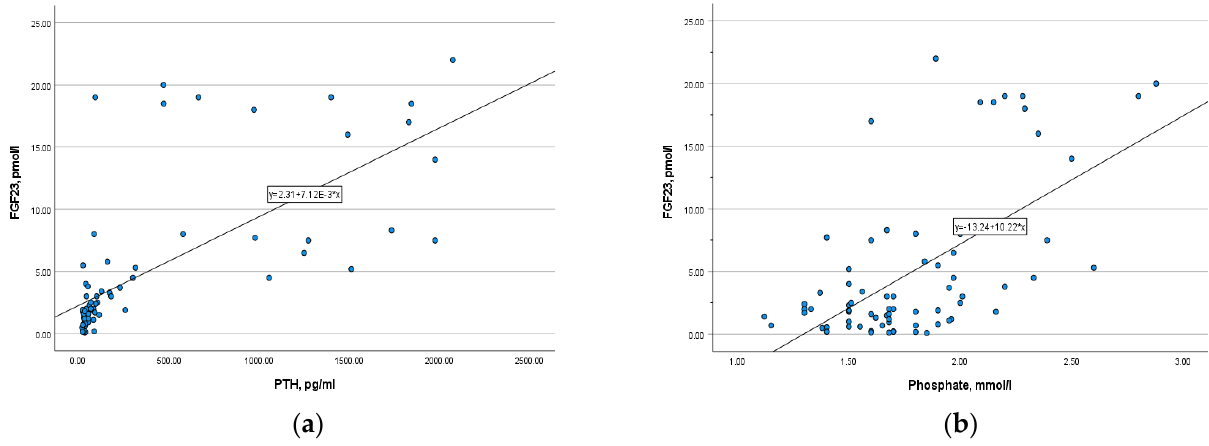
Figure 6. ( a ) The correlation of FGF-23 with PTH ( r = 0.807, p = 0.000); ( b ) the correlation of FGF-23 with serum phosphate ( r = 0.473, p = 0.000).